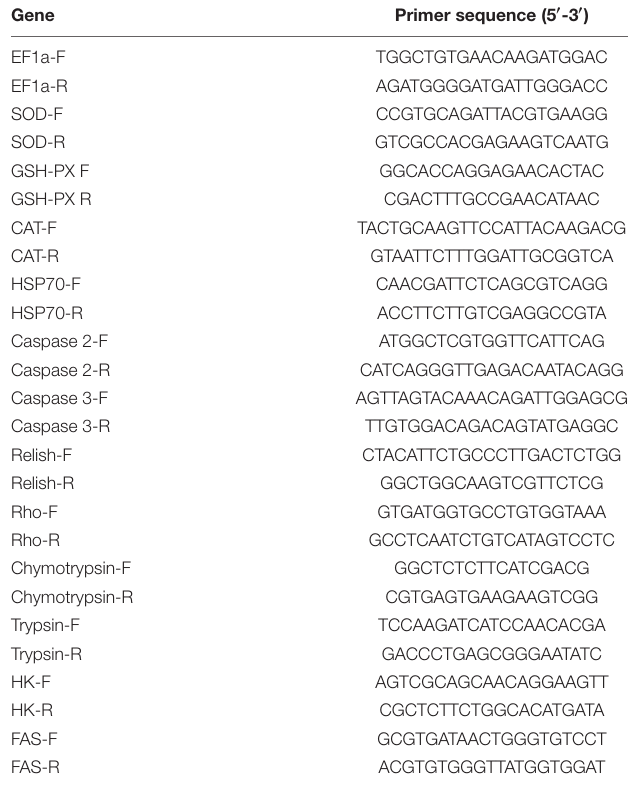
TABLE 2 | Sequences of primers used for real-time quantitative